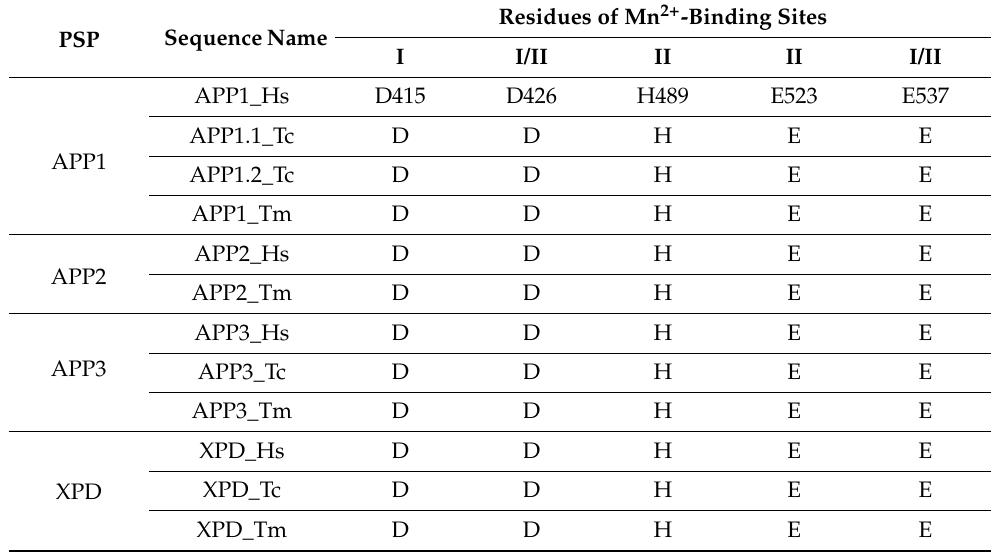
Table 3. General characteristics of the metallodependent PSP sequences from the M24B subfamily.